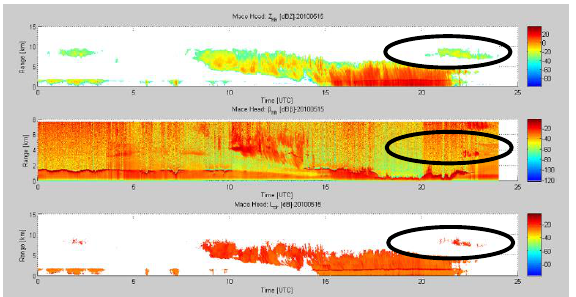
Figure 2: Range-time section of copolar reflectivity Z hh (36GHz) and linear depolarization ratio L dr (36GHz) from MIRA36 (upper and lower panel) and copolar backscatter coef- ficient  hh (1064nm) from CHM15K (middle panel) on May 15, 2010. The black circles indicate the ash signature.